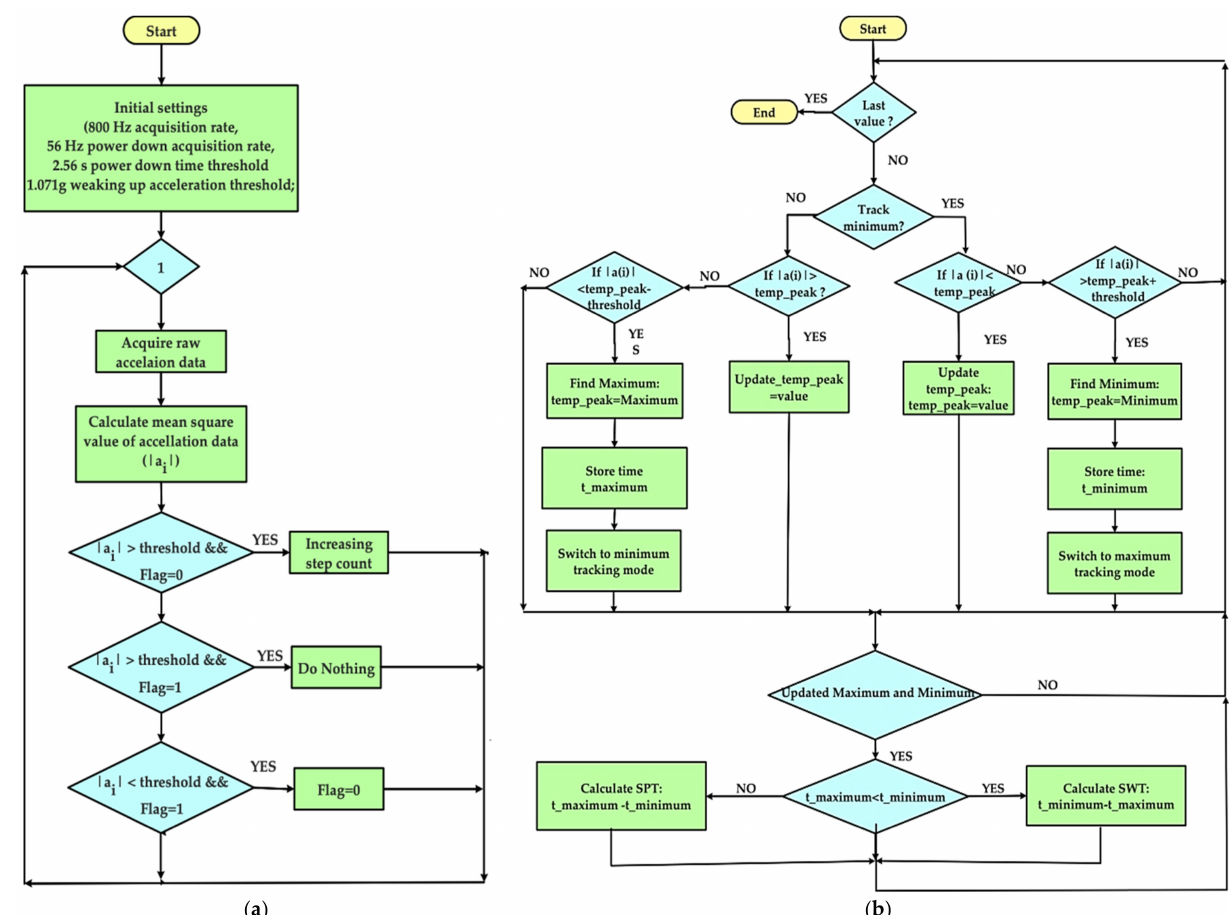
Figure 23. Flowchart related to the pedometer implemented inside the developed smart insole ( a ) and peak detector used to determine the SWT and SPT parameters ( b